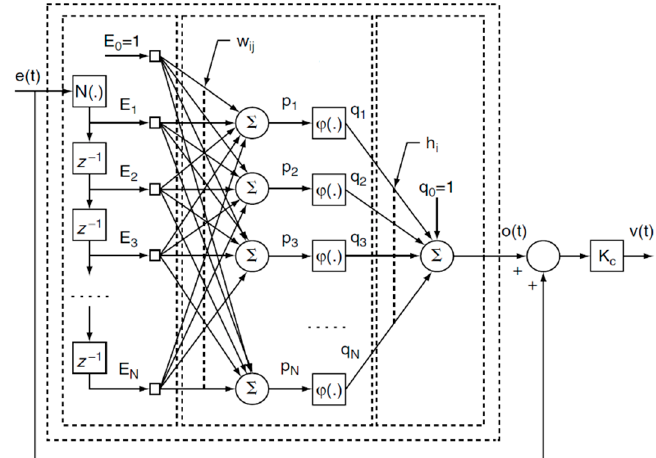
Figure 7. Architecture of the ANN-based model-free adaptive (MFA) controller: e ( t ) is the tracking error; z -1 is the discrete delay function; E i is the i th error signal; w ij is the ij th weight in the hidden layer; p j is the input of the j th activation function in the hidden layer; φ is a sigmoidal activation function; q j is the output of the j th activation function in the hidden layer; h j is the j th weight of the output layer; o ( t ) is the continuous function of the output; K C is the controller gain coefficient; and v ( t ) is the continuous function of the controller output.